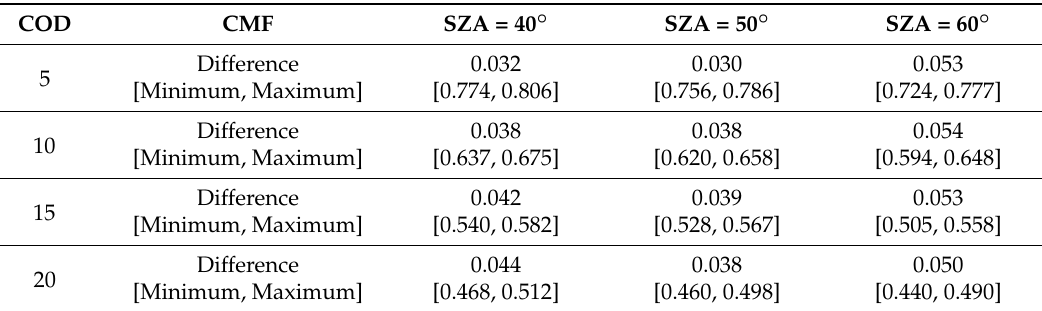
Table 4. The maximum and minimum values of theoretical CMFs and its spectral difference within the spectral range from 300 to 360